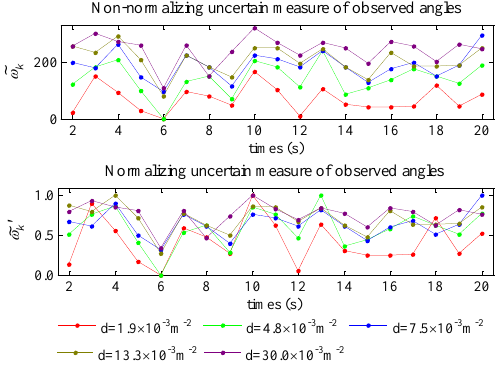
Figure 4. Variation curves of uncertain measures of observed angles.